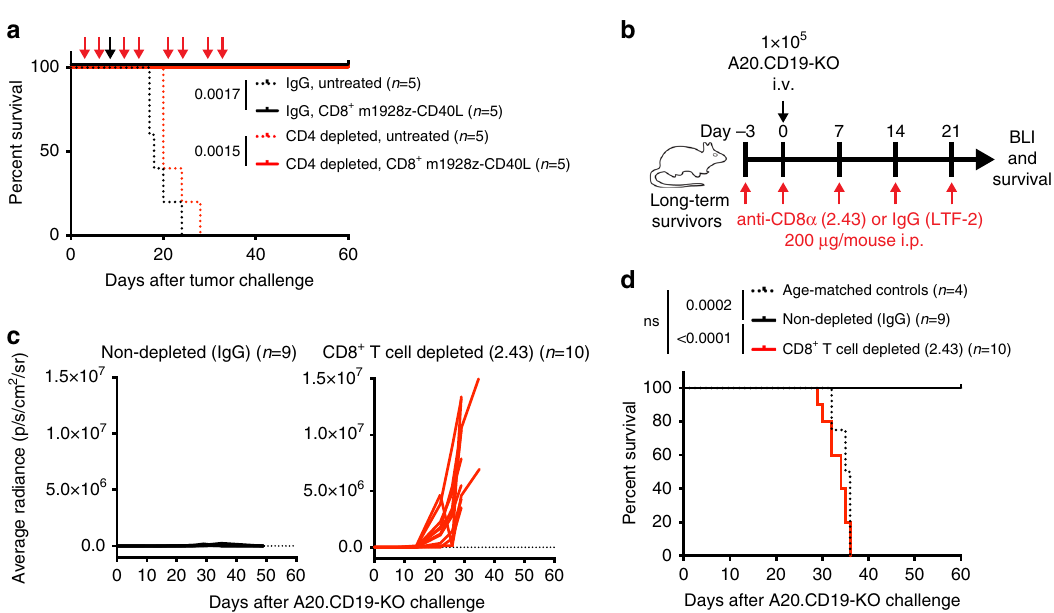
Fig. 4 CD8 + T cells are necessary for m1928z-CD40L CAR T cell-mediated protection against antigen-negative tumor growth. a Survival of naive BALB/c mice injected with 1 × 10 6 A20.GL cells intravenously (i.v.) and either left untreated or treated with 3 × 10 6 CD8 + m1928z-CD40L CAR T cells i.v. on day 7 (black arrow). For CD4 + T cell depletion, two cohorts of mice received 200 μ g of anti-CD4 depletion antibody (GK1.5) by intraperitoneal (i.p.) injection 2x per week for 3 – 4 weeks (red arrows). One of two representative experiments is shown. b Experimental scheme for ( c , d ). c Tumor burden of mice injected with luciferase-expressing CD19 neg A20.CD19-KO cells was monitored using bioluminescence imaging. Average radiance per whole animal is plotted for the IgG treated mice ( n = 9) and the CD8 + T cell-depleted mice ( n = 10). d Survival of mice treated in ( b , c ). Naive age-matched BALB/c mice were used as controls. All p -values in fi gure were determined by a two-tailed log-rank (Mantel-Cox) test. ns, non-signi fi cant. Source data are provided as a Source Data fi